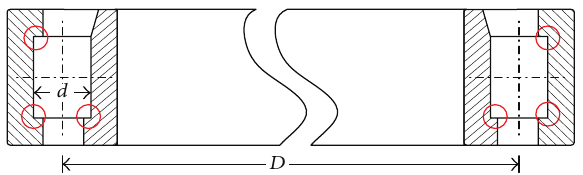
Figure 2: Structure of the cylindrical roller